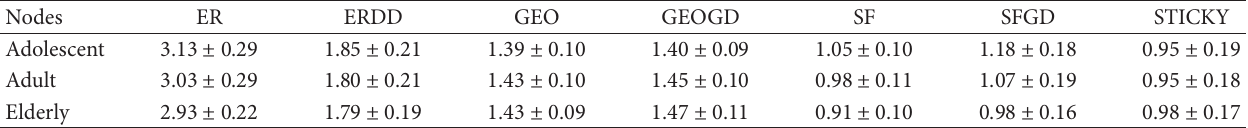
Figure 4: The comparison of small-worldness and global efficiency between SF-GD, STICKY and the real brain networks. (a) Small- worldness. (b) Global efficiency. Table 1: Average RGF distance in different groups.